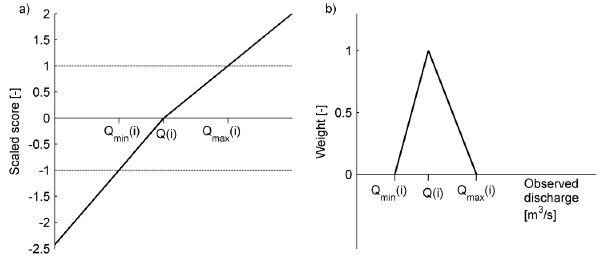
984 Fig. 5. (a) Calculation of the scaled scores, Q min (i) is the lower Fig. 5 a) Calculation of the scaled scores, Q min (i) is the lower limit for the discharge 985 limit for the discharge uncertainty at the i :th evaluation point (EP), uncertainty at the i:th evaluation point (EP), Q max (i) the upper limit and Q(i) the crisp 986 Q max (i) the upper limit and Q(i) the crisp discharge. A simulated discharge. A simulated value that is at the crisp value gets a scaled score of 0, if the value is at 987 value that is at the crisp value gets a scaled score of 0, if the value is at the lower limit a scaled score of − 1 and at the upper limit it is 1, the lower limit a scaled score of -1 and at the upper limit it is 1, values within or outside are 988 values within or outside are linearly inter- or extrapolated; (b) trian- linearly inter- or extrapolated; b) triangular weighting function applied at each EP such that 989 gular weighting function applied at each EP such that weights are weights are zero for scaled scores outside the range [-1, 1]. 990 zero for scaled scores outside the range [ − 1, 991 992